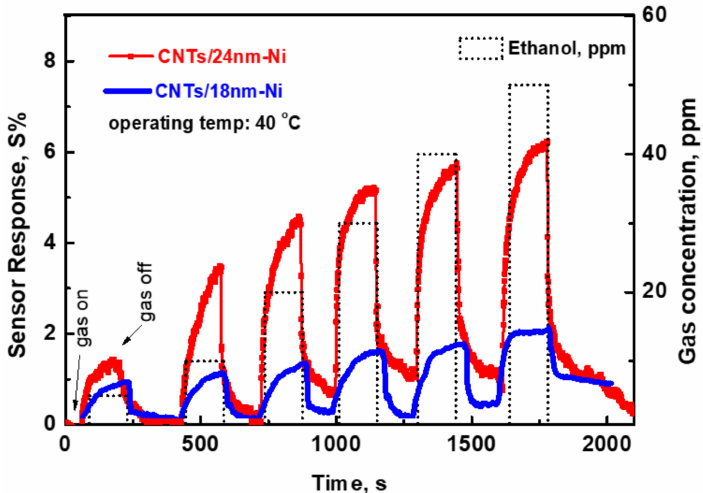
Figure 6. Sensor signal versus time at various gas concentrations for the sensor prepared with 18 nm and 24 nm of Ni catalyst